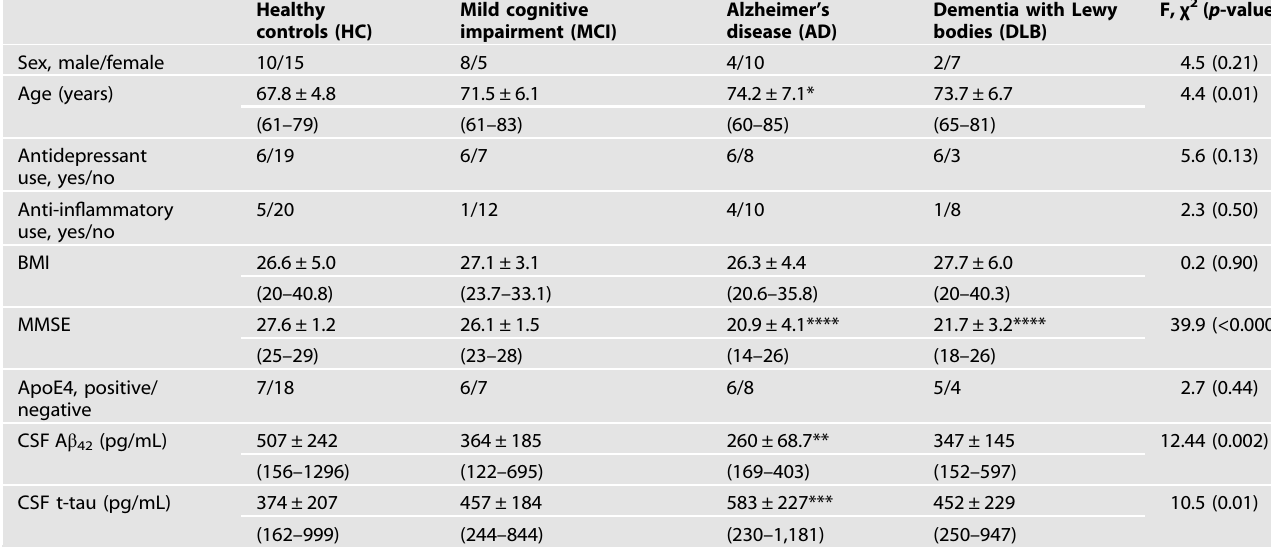
Table 1. Demographic, clinical, and biomarker characteristics of donor